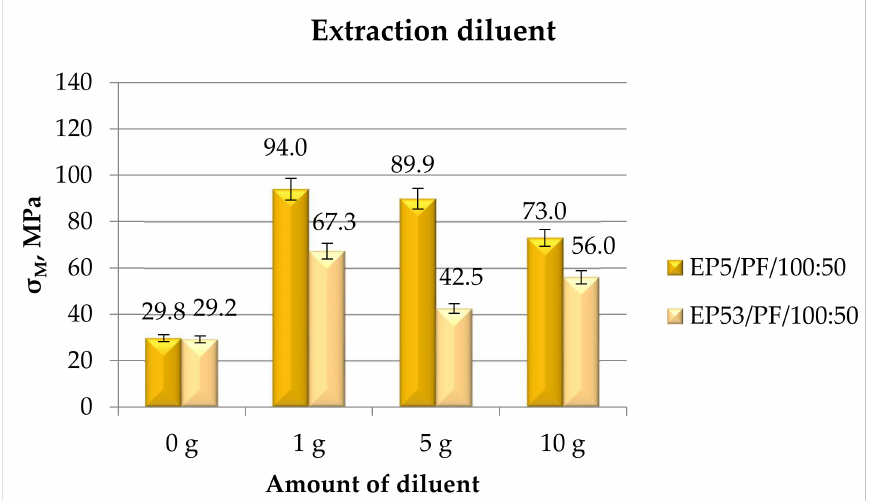
Figure 14. Compressive strength calculated for Epidian 5 and Epidian 53 epoxy compounds as a function of the amount of extraction